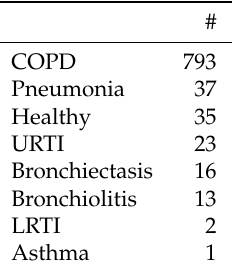
Table 6. Number of samples for each